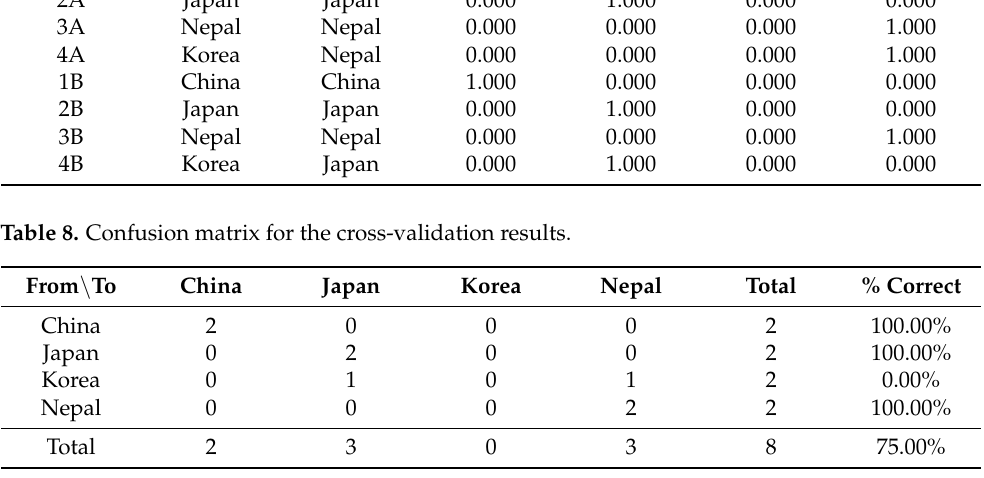
Table 7. Cross-validation: Prior and posterior classification, membership probabilities, scores, and squared distances. Observation Prior Posterior China